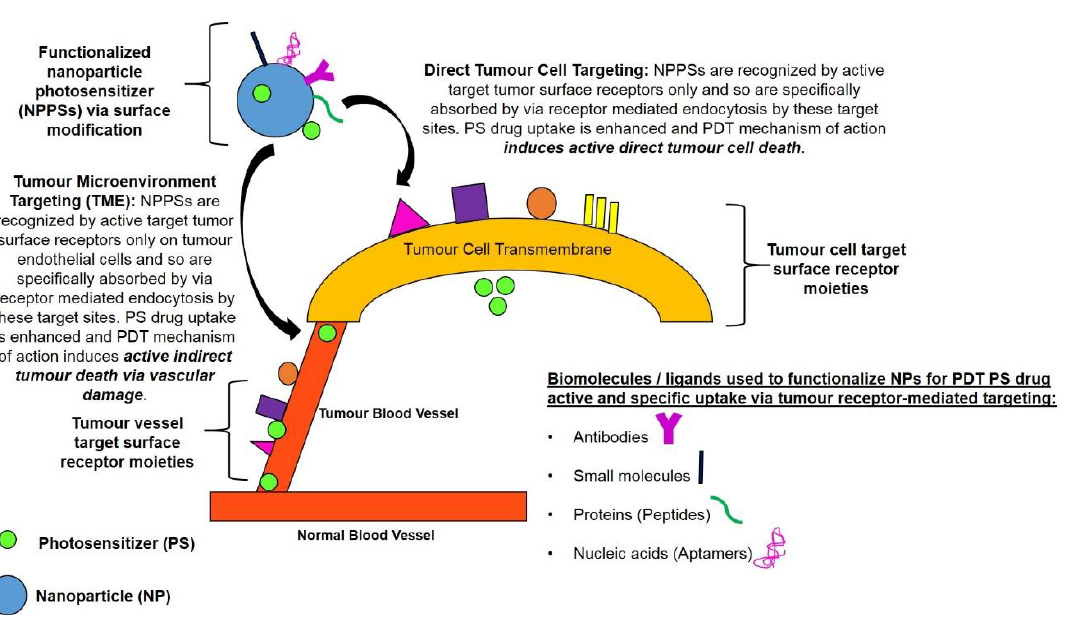
Figure 4. Diagram showing specifically active and targeted PS drug delivery to tumours via receptor mediated targeting. Tumour absorption of functionalised NPPSs is significantly increased via their surface modification with specific biomolecules or ligands. This active targeting mechanism takes advantage of highly specific interactions between biomolecules/ligands and certain TME tissues/blood vessels or cell surface antigens (receptor moieties) to increase cellular uptake and tumour retention of PS drugs. These active NPPSs drug systems enhance overall PS uptake in tumour cells only, which significantly enhances PDT induced tumour destruction, with the additional advantage that normal cells/tissues remain unaffected.